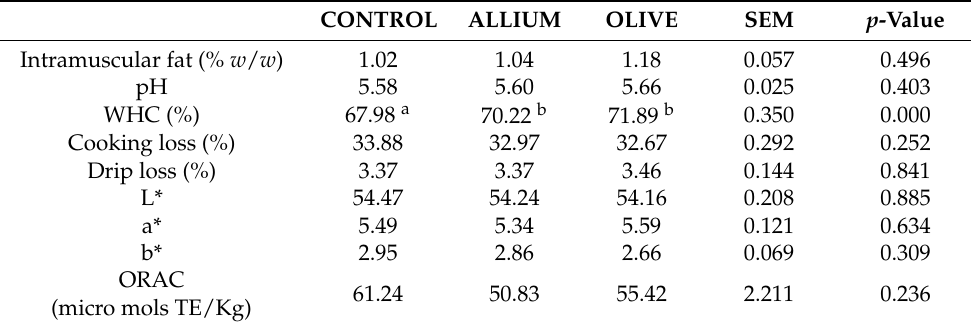
Table 3. Mean scores of the meat quality parameters analyzed in loin from pigs fed three different treatments. CONTROL ALLIUM OLIVE SEM p -Value Intramuscular fat (% w / w )